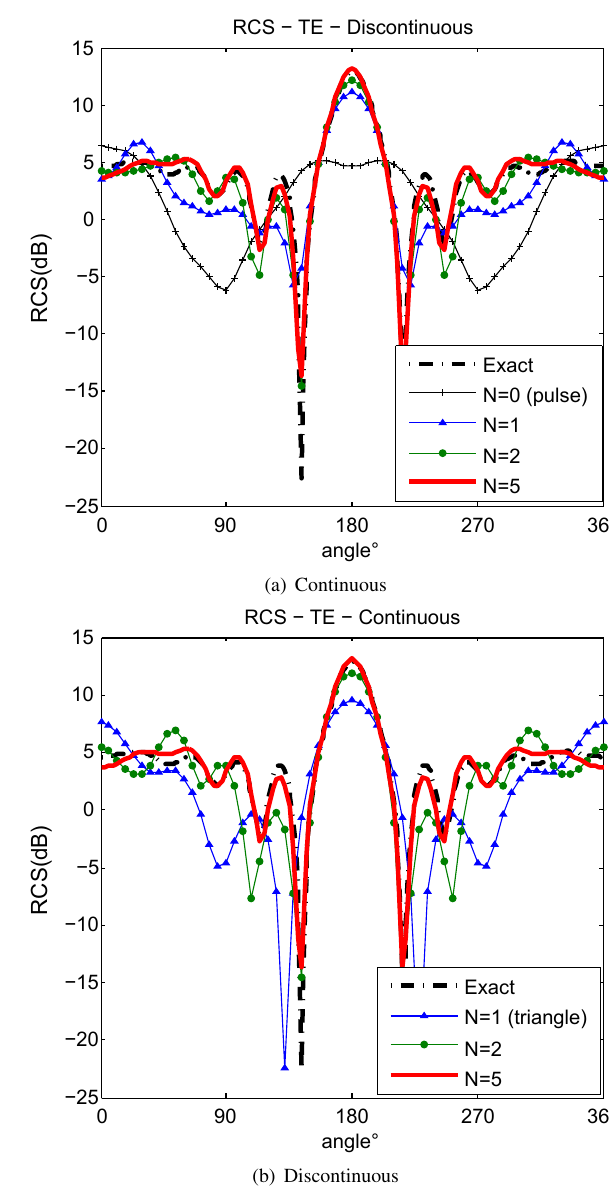
Figure 13: (TM polarization) RCS estimation with different orders for r = λ , L = λ